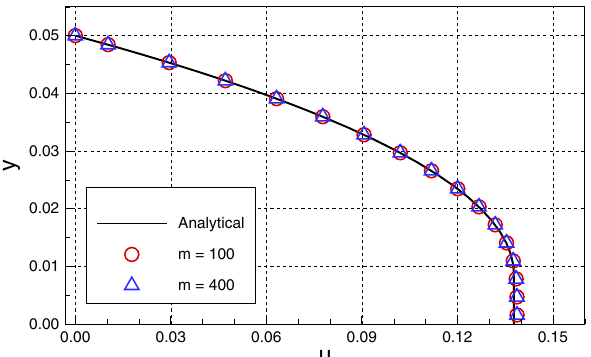
Figure 2. Comparison of analytical and numerical solutions for steady-state fluid velocity for Poiseuille flow of a Bingham fluid.